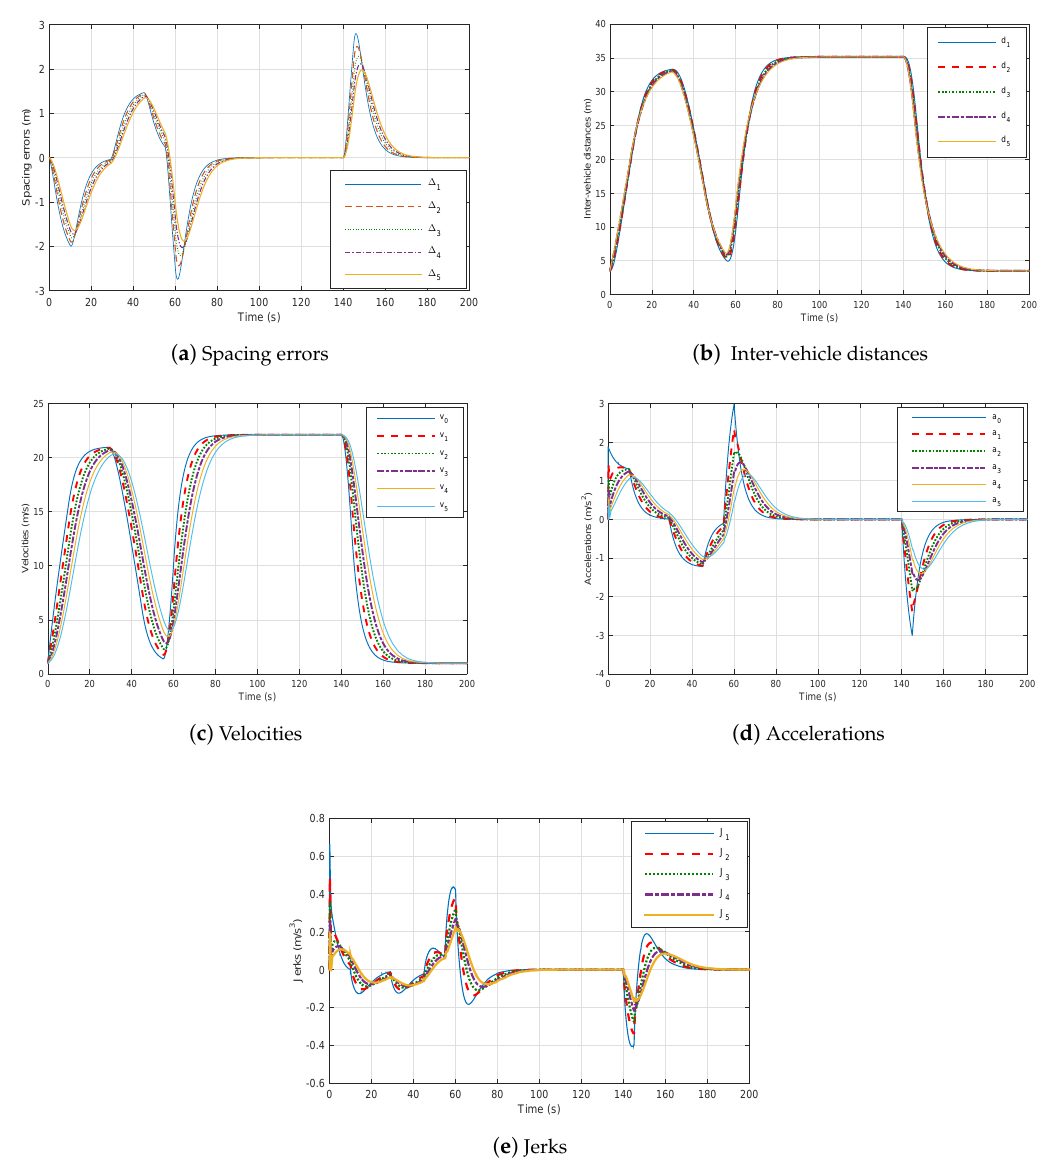
Figure 6. Six-vehicle platoon system under controller (49) without communication network with h d =